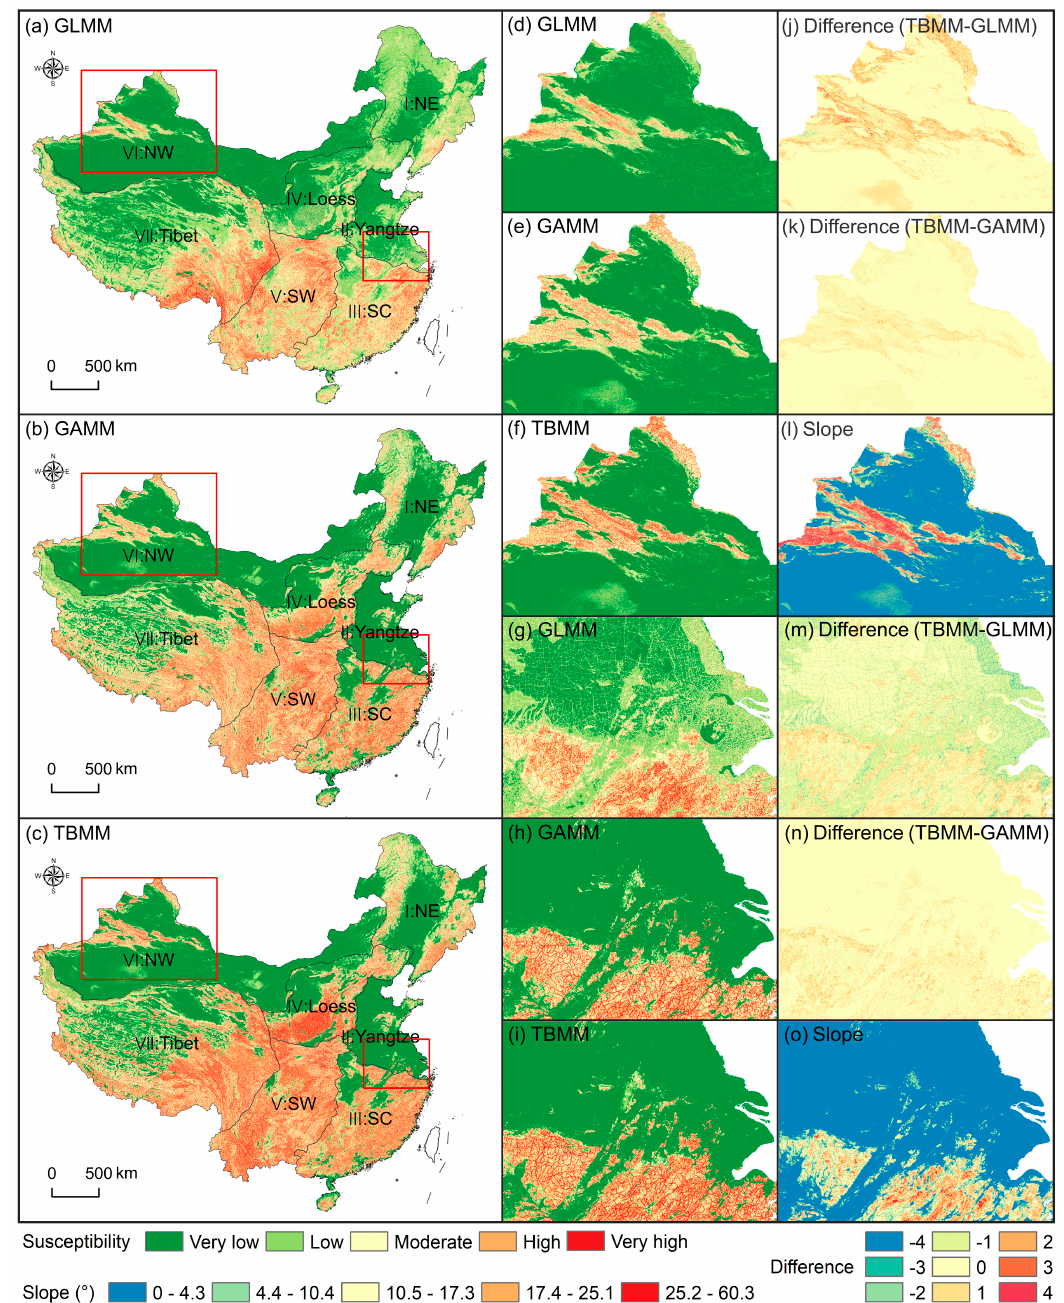
Figure 10. Landslide susceptibility maps. ( a–i ) Susceptibility maps for China and local areas generated by three mixed models; ( j,k,m,n ) the difference between TBMM and other models in local areas; ( l,o ) the topography slope in local areas.